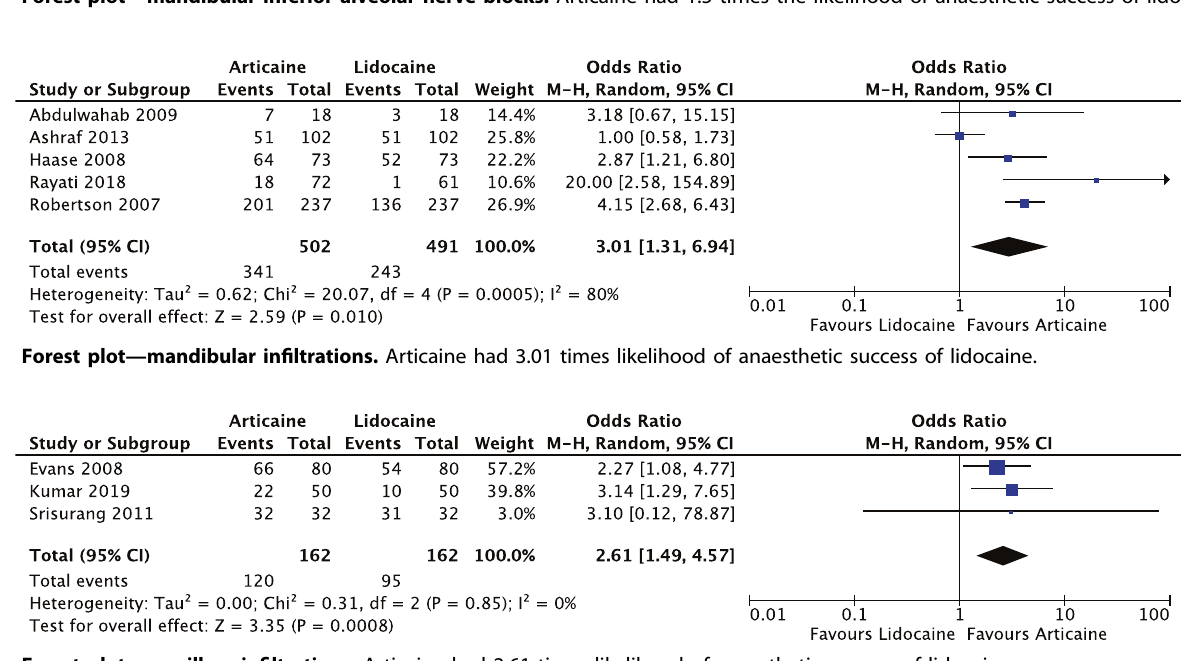
signi fi cance ( P = 0.006). For symptomatic teeth, articaine had 1.89 times higher likelihood of anaesthesia success of lidocaine with signi fi cance ( P = 0.02). Study design . Meta-analysis was performed for the differences in parallel compared to crossover studies. Study design appeared not to in fl uence anaesthesia outcomes in this meta-analysis. The